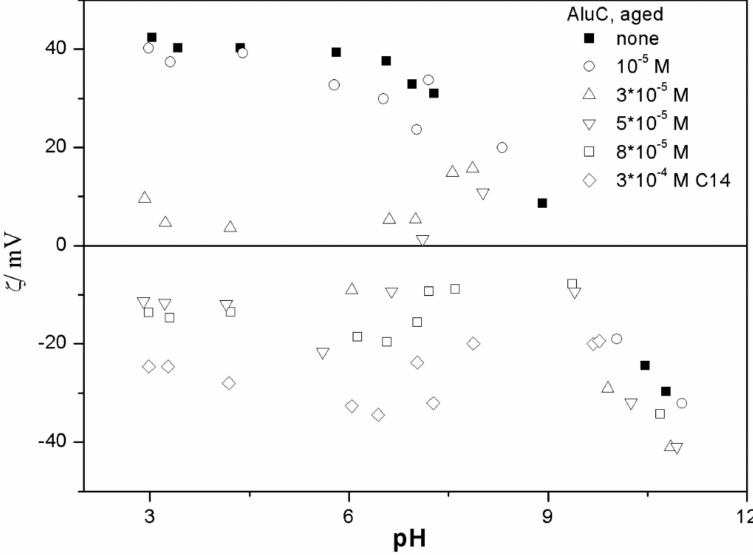
Figure 7. The ζ potential of alumina in aged dispersions in the presence of sodium tetradecylsulfate.